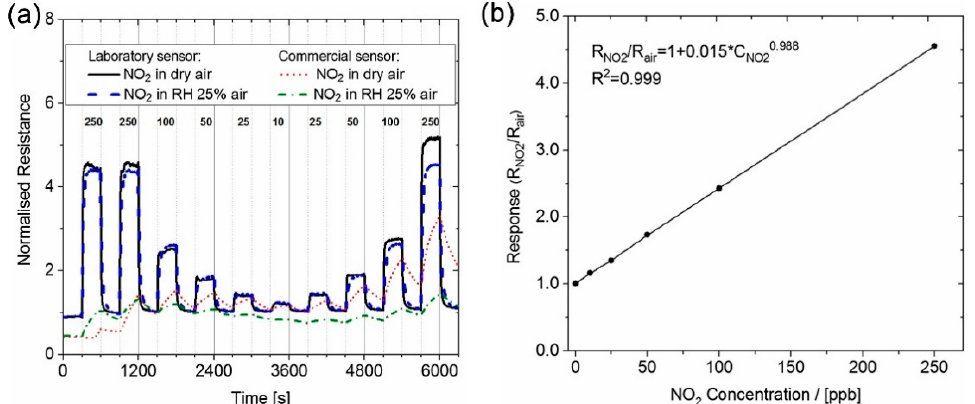
Figure 2. ( a ) The response of a laboratory WO 3 based gas sensor and commercial MOX sensor with respect to NO 2 in dry and humid air ( b ) response of the laboratory sensor as a function of NO 2 concentration (from [33]).